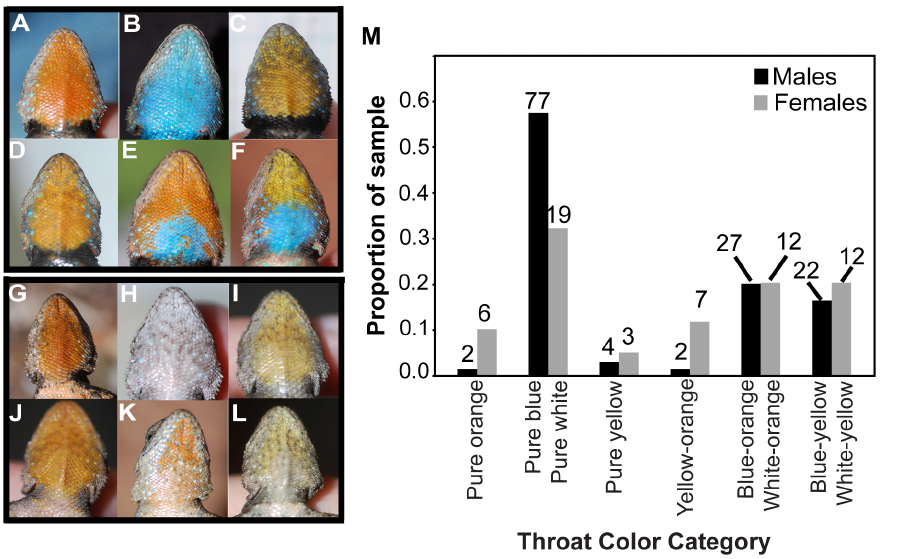
Figure 1. Male and female throat color morphs present in S.grammicus at CPN. A–F: Male morphs. A. Pure orange. B. Pure blue. C. Pure yellow. D. Yellow-orange. E. Blue-orange. F. Blue-yellow. G–L: Female morphs. G. Pure orange. H. Pure white. I. Pure yellow. J. Yellow-orange. K. White- orange. L. White-yellow. M. Frequencies of male and female throat color morphs among all lizards captured at CPN in 2011. Sample sizes above bars.